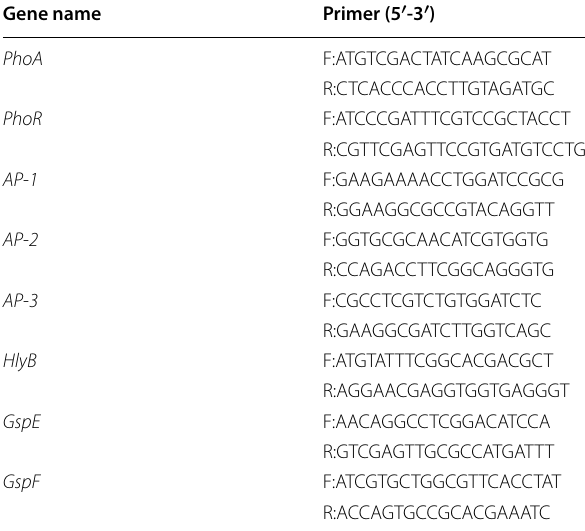
Table 1 Specific primers for qRT-PCR of Burkholderia multivorans WS-FJ9 phosphate-solubilizing